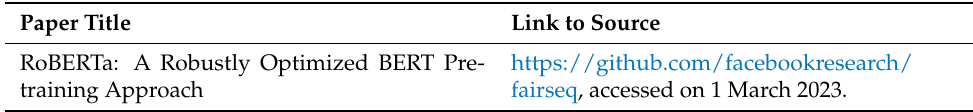
Table 9. Source code links for Information Retrieval.